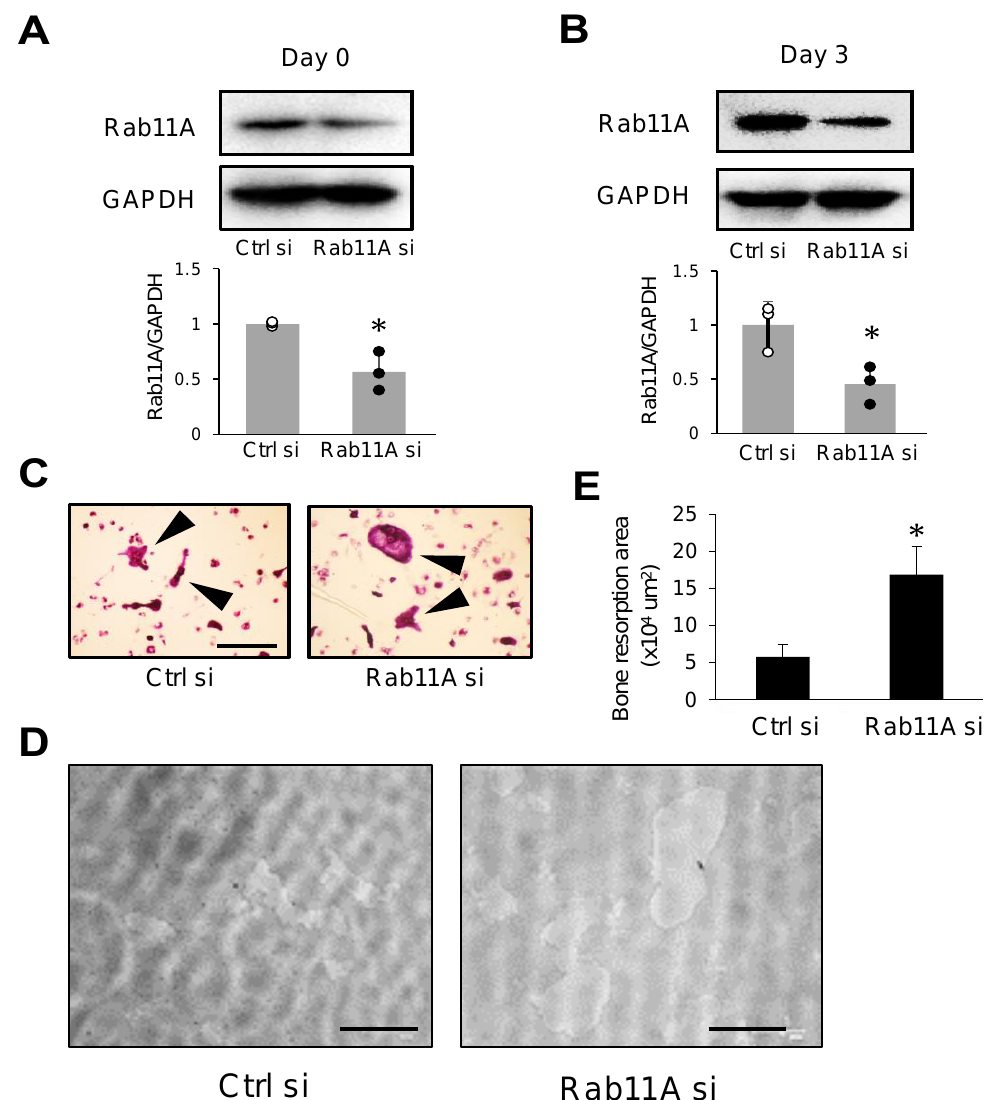
Figure 3. The e ff ects of Rab11A silencing on BMM-derived osteoclast di ff erentiation. ( A ) Upper: BMM cells were transfected with nontargeting siRNA (Ctrl si) or Rab11A-specific siRNA (Rab11A si) for 24 h without RANKL stimulation. Lower: Column scatter plotting to compare Rab11A protein level. ( B ) Upper: BMM cells were transfected with Ctrl siRNA or Rab11A siRNA for 24 h, followed by RANKL stimulation for 3 days. The endogenous level of Rab11A protein was evaluated by Western blotting. Lower: Column scatter plotting to compare Rab11A protein level. ( C ) TRAP staining of osteoclast transfected Ctrl si or Rab11A si. Arrowheads showed large osteoclasts. Bars: 200 µ m. ( D ) Images of the bone resorption area of BMM-derived osteoclasts transfected with Ctrl si or Rab11A si. Bars: 100 µ m. ( E ) The resorption area was determined using Image J software. The data are represented as mean ± SD of values from three independent experiments. * p < 0.05, compared to control cells.